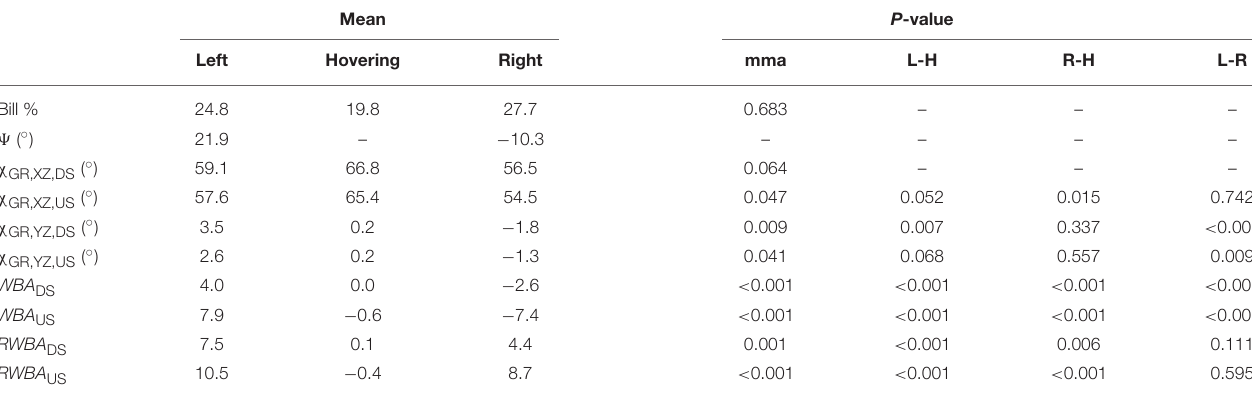
TABLE 1 | Mixed model ANOVA (mma) of kinematics: bill percentage inserted in feeder (Bill %), travel angle ( 9 ), lateral body angle ( χ GR,XZ ), frontal body angle ( χ GR,YZ ), wing bank angle ( WBA ), and relative wing bank angle ( RWBA ) by maneuver (left lateral flight, hovering, right lateral flight). Mean P -value Left Hovering Right mma